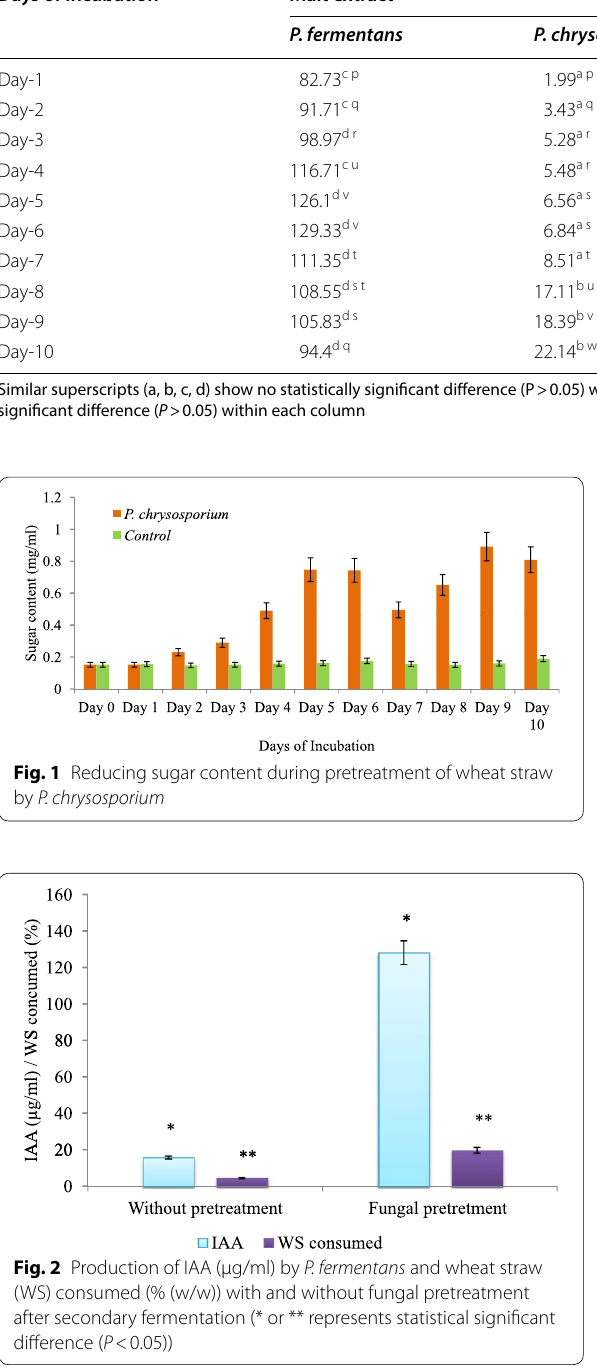
Table 2 Production of IAA (µg/ml) at different days by P. fermentans and P. chrysosporium